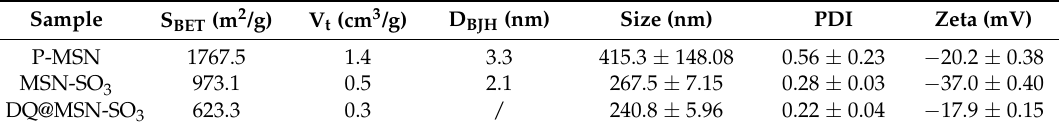
Figure 5. Thermogravimetric analysis (TGA) curves ( A ), X-ray photoelectron spectroscopy (XPS) spectra ( B ), Nitrogen adsorption-desorption isotherms ( C ), and pore size distributions ( D ) of nanoparticles. Table 1. Mesoporous structure characterization of nanoparticles a